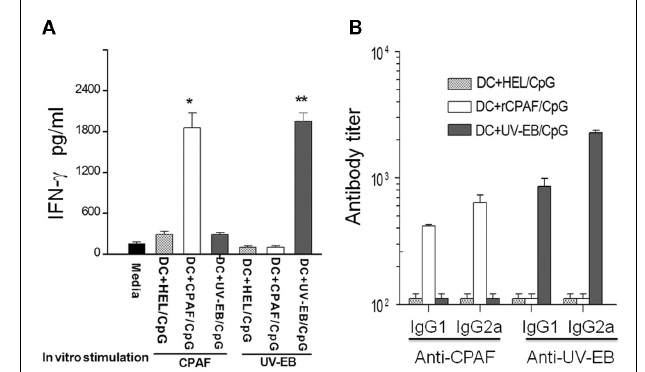
FIGURE 2 | BMDCs pulsed ex vivo with CpG, rCPAF + CpG, UV-EB + CpG secrete IL-12. BMDCs were cultured in medium alone as a control or following pulsing with CpG, rCPAF + CpG, UV-EB + CpG for 4h; the cells were than washed and incubated for 24h. Culture supernatants were collected and assayed by ELISA for IL-12, IL-10, and IL-4.The results are one of two independent experiments with similar results. ( ∗ ) Statistically significant differences ( p < 0.01; ANOVA) between the indicated group and medium-pulsed BMDC are shown.